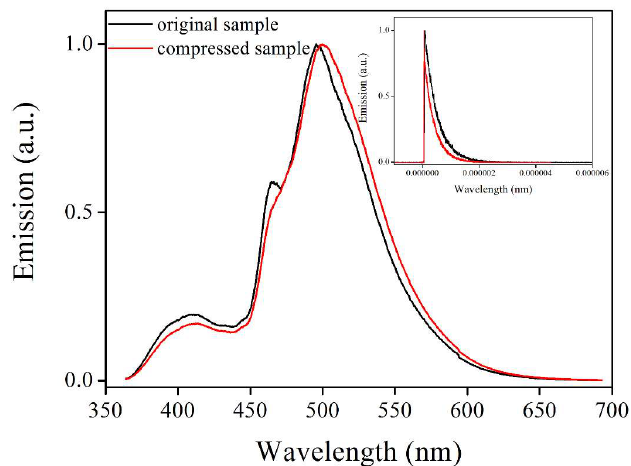
Figure 6. Emission spectra of Ir(ppy) 2 (BPE) solid before and after its being treated with a pressure of 1 MPa. Inset: emission decay dynamics of Ir(ppy) 2 (BPE) solid before and after its being treated with a pressure of 1 MPa.